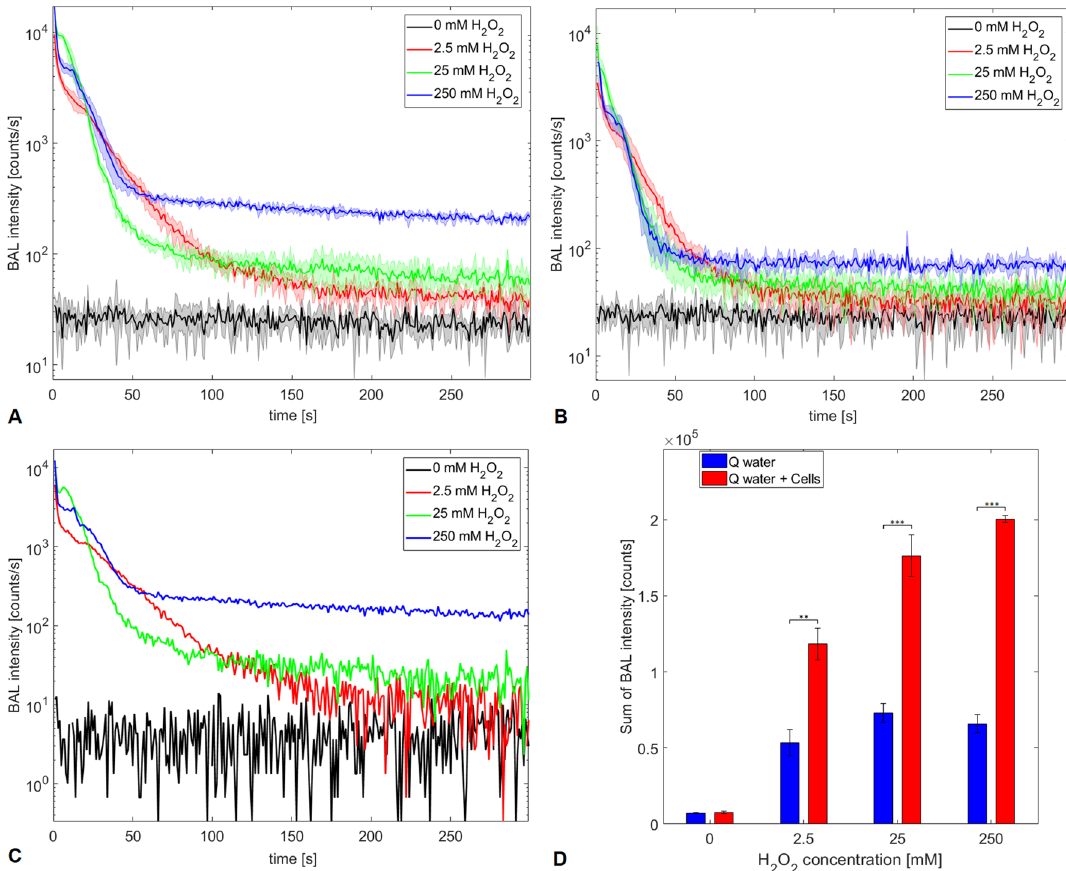
Figure 3. BAL from yeast cell culture under chemically induced oxidation. ( A ) The BAL time dynamics from yeast cell samples in purified water with three different concentrations of hydrogen peroxide ( H 2 O 2 ) and fixed Fe 2 + concentration (0.5 mM). ( B ) The BAL time dynamics from control samples: purified water (Q water) with the same concentrations of hydrogen peroxide ( H 2 O 2 ) and fixed Fe 2 + concentration. ( C ) The difference in BAL time dynamics between cell samples and control samples. The BAL signals from control samples ( B ) are subtracted from those with cells ( A ). ( D ) The sum of BAL intensity throughout the measurements, ** p < 0.01 ; *** p < 0.001 . The sum is calculated as the area under curves in A : Q water + Cells and ( B ) Q water. The data represent mean values from 3 repetitions of experiment and the error bars represent the standard